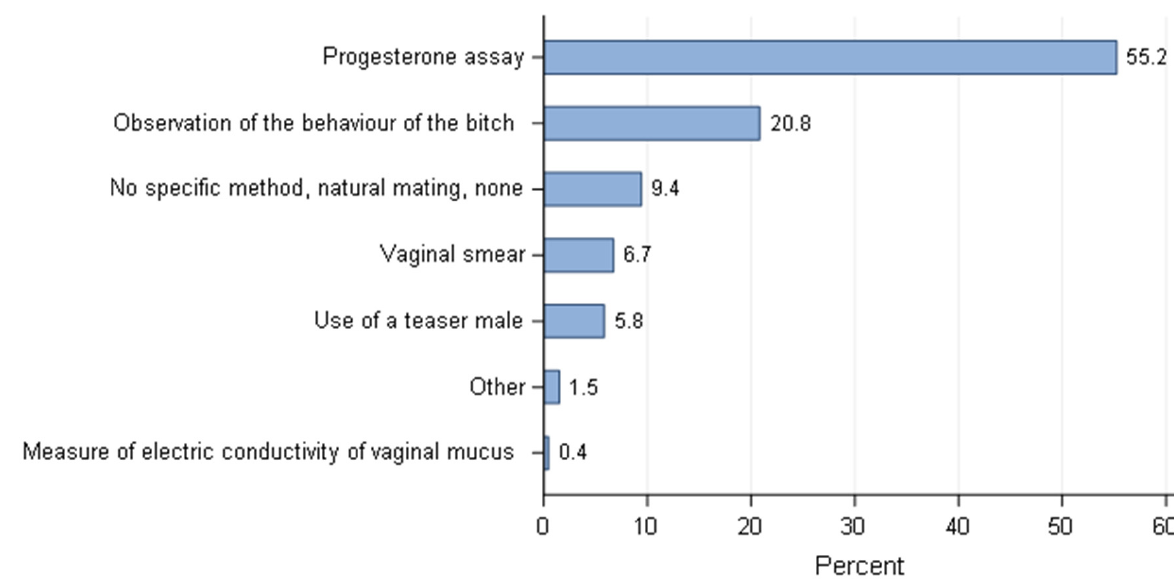
Figure 7. Methods to estimate the breeding time (most often used) overall distribution—all responders ( n = 668).